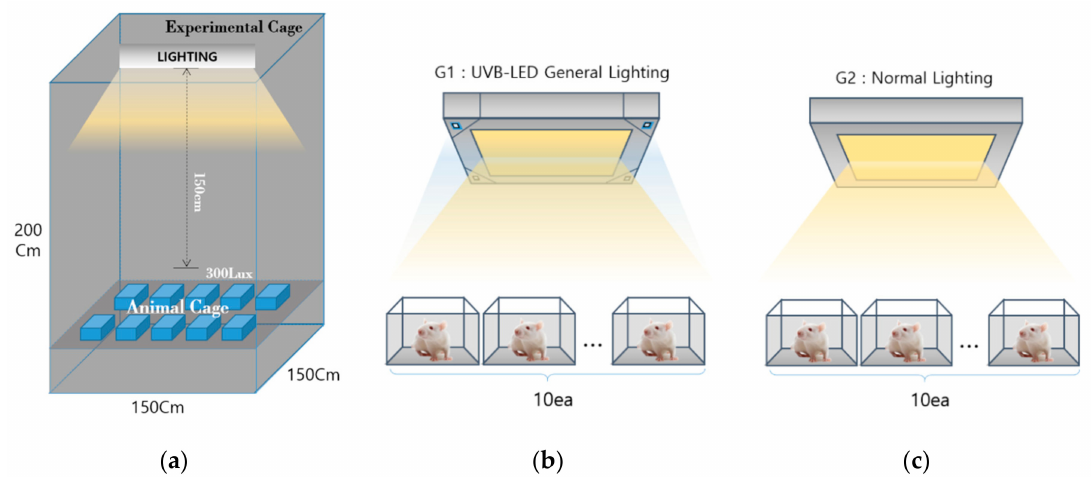
Figure 4. Animal testing environment. ( a ) Cages for animal testing. ( b ) Test group G1: UVB-LED general lighting. ( c ) Test group G2: normal